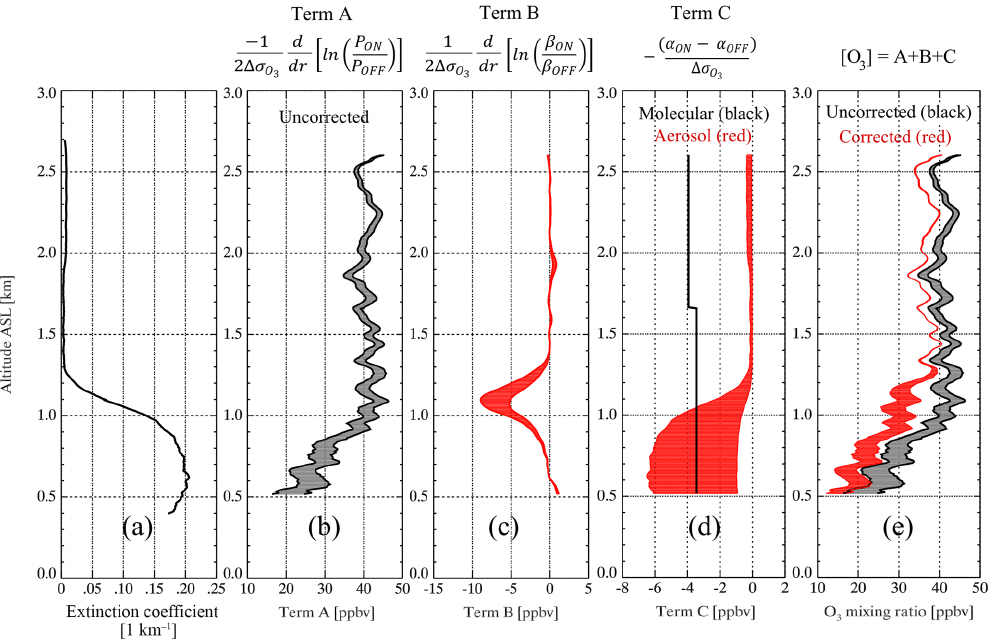
Figure 4. O 3 retrieval and aerosol correction for the AN:276 / 299 (altitude above 1.65km) and PC:266 / 299 (below 1.65km) wavelength pairs shown in Fig. 3. (a) The aerosol optical extinction coefficient derived using the lidar measurement at a wavelength of 532nm. Calculation of term A (b) , term B (c) , and term C (d) from Eq. (2). (e) The addition of the first three terms in Eq. (2). The shading in red represents the range of O 3 values due to the uncertainty in the aerosol correction method. The grey shading represents the statistical uncertainty in the detection. The measurements shown here were collected on 23 August 2013 at 13:15 local time (UTC − 6h) as the Twin Otter flew directly above the oil sands